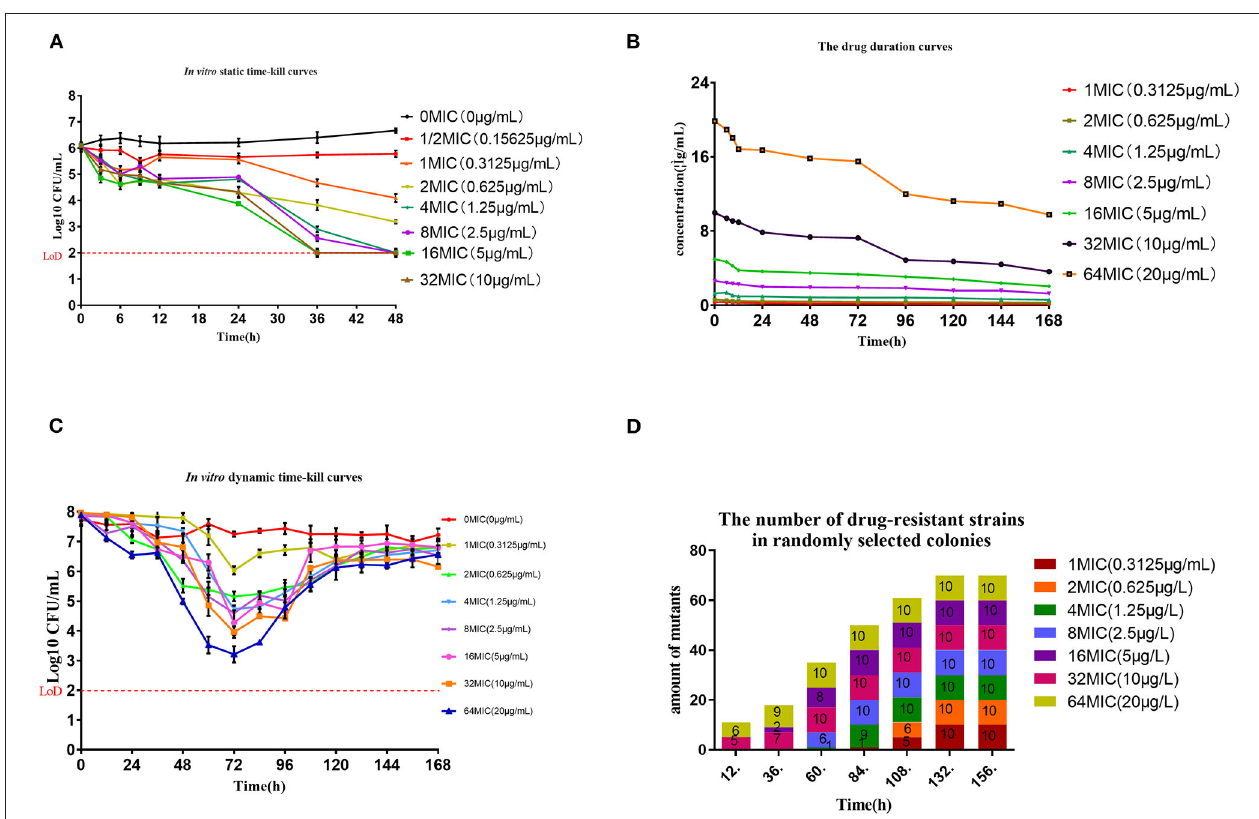
FIGURE 1 | Pharmacokinetic and pharmacodynamic results in dynamic models. (A) Time-kill curves for tulathromycin at constant concentrations. The red dash represents the method detection limit (B) Concentration-time curves for 7 levels of tulathromycin for the in vitro dynamic model. (C) Dynamic time-kill curves